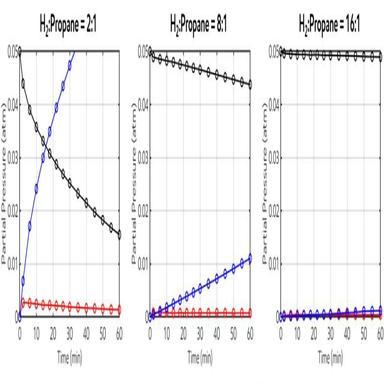
Propane reactivity on Pt-only at 450 C, at varying H2:propane ratios (left: 2:1, middle: 8:1, right: 16:1). Plots show hydrocarbon partial pressure (black: propane; red: propylene; blue: sum of ethane, ethylene and methane) as a function of time. (For interpretation of the references to colour in this figure legend, the reader is referred to the web version of this article.)